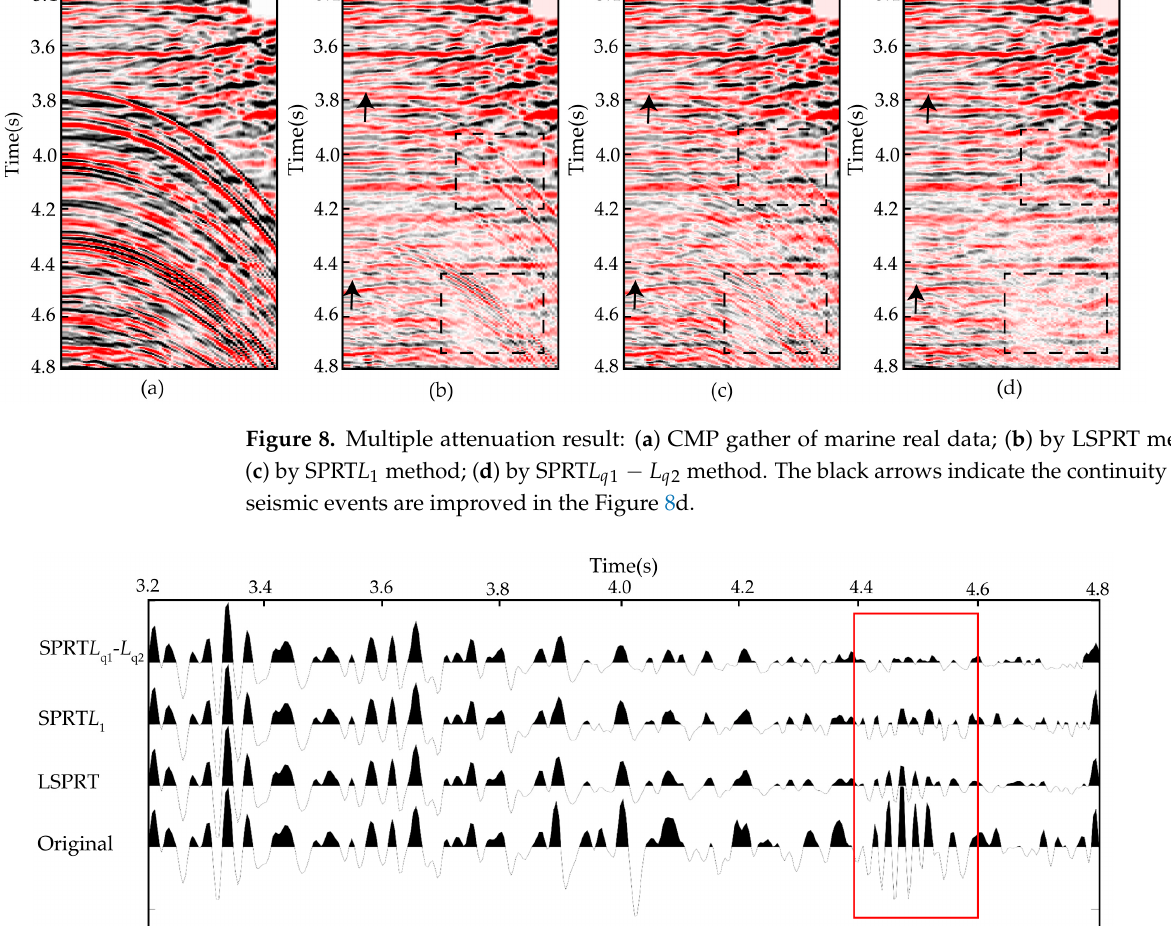
Figure 8. Multiple attenuation result: ( a ) CMP gather of marine real data; ( b ) by LSPRT method; ( c ) by SPRT 𝐿 (cid:2869) method; ( d ) by SPRT 𝐿 (cid:3044) seismic events are improved in the Figure 8d.